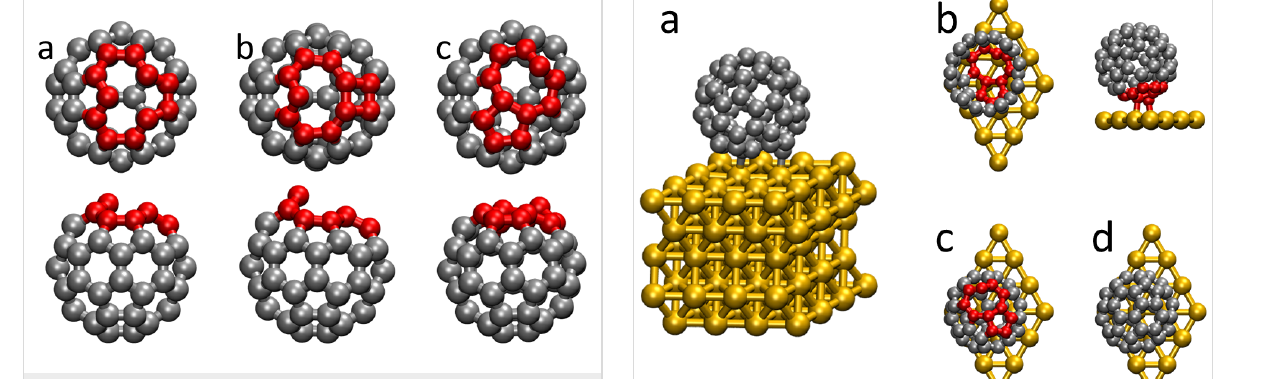
Figure 3: Top and side views of the computed structure of C 59 struc- tural isomers. Carbon atoms around the vacancy are shown in red. (a) Initial structure for geometry optimization, obtained from a C 60 mol- ecule by removing one atom. (b) Isomer where the atoms around the vacancy form one four- and one nine-membered ring. (c) More stable isomer having eight- and five-membered rings. C atoms belong to both rings, but for clarity we choose to name them according to the total number of atoms in each ring. At the optimized structures, both C 59 isomers have a carbon atom protruding from the shape of a C 60 molecule or that of a C 60 molecule with one missing C atom (the starting geometry of the structural optimizations). Despite the structural rearrangement, interatomic C–C bond distances are not dramatically altered.